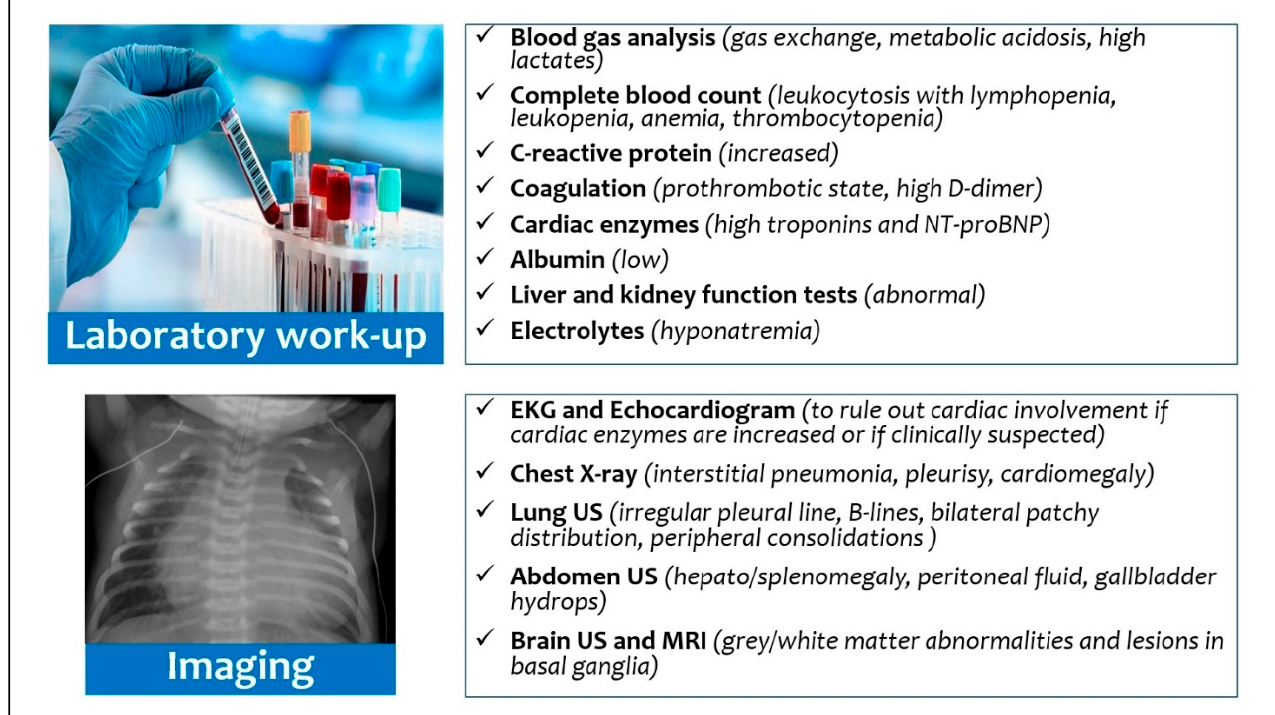
Figure 4. Diagnostic work-up for multisystem inflammatory syndrome in neonates and infants.